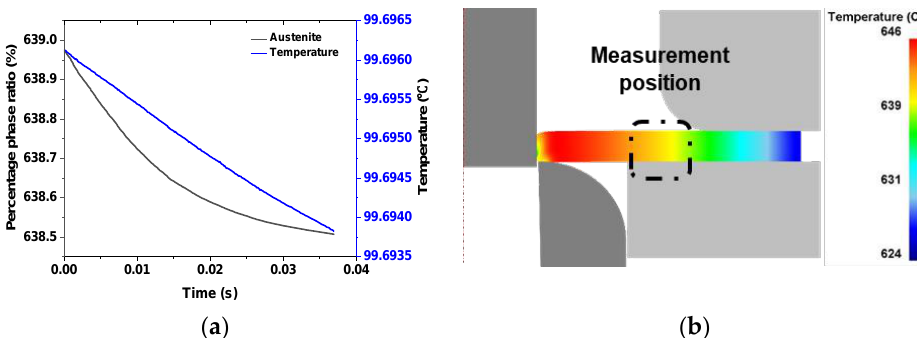
Figure 5. Material temperature and phase distribution after the piercing process; ( a ) austenite volume fraction/temperature change; ( b ) temperature distribution.